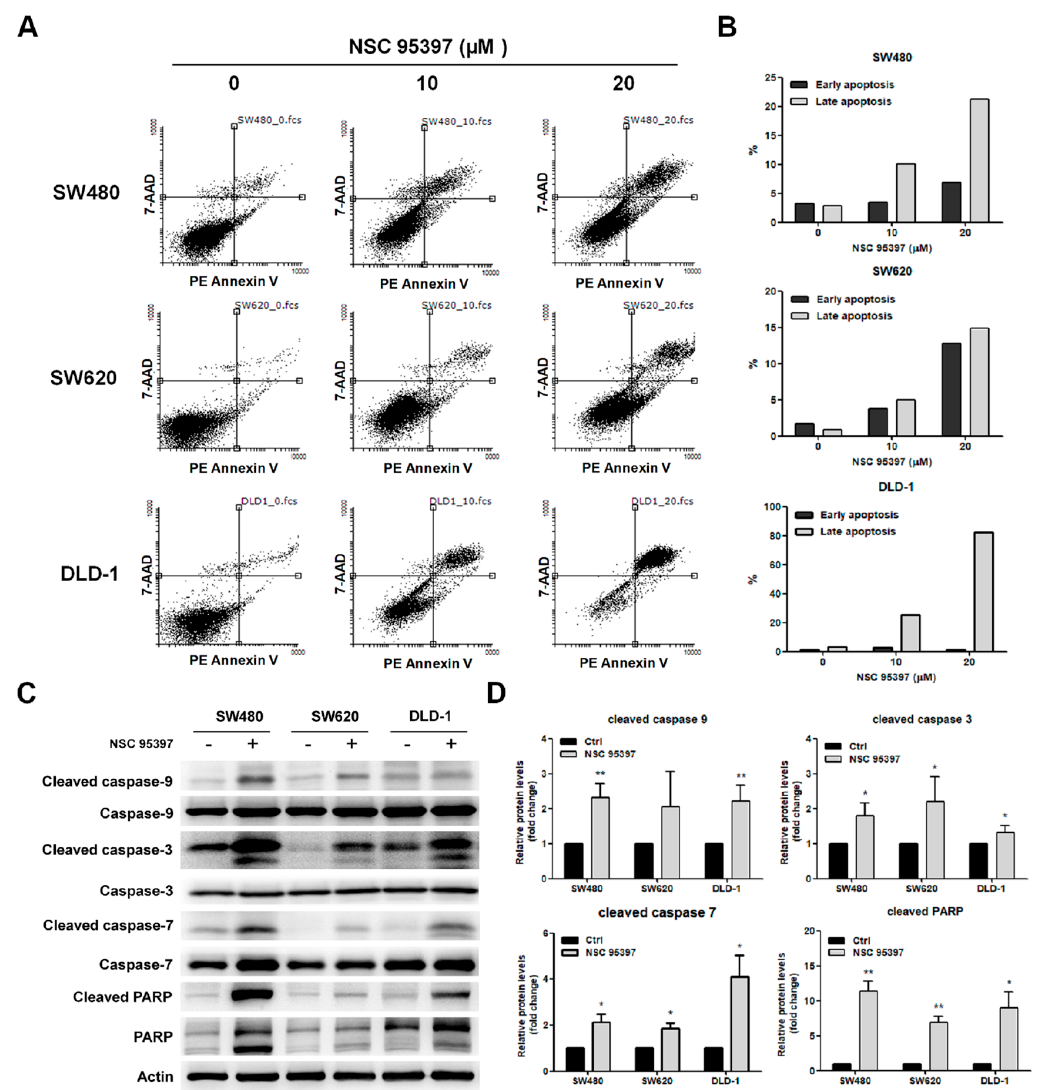
Figure 4. Apoptosis induction of NSC 95397 in human colon cancer. ( A ) Flow cytometric analysis